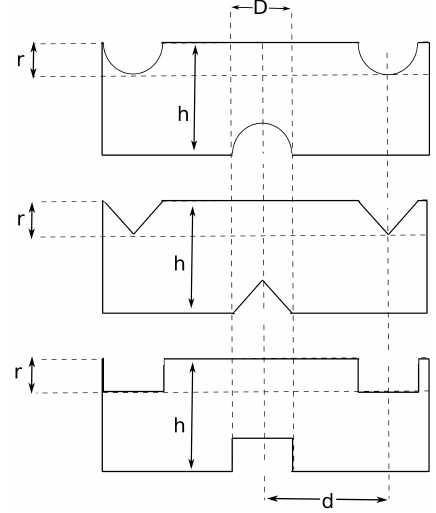
Figure 4. Schematic of the different corrugations (cylindrical, triangular and square) with characteristic parameters. Table 1. Characteristic parameters of corrugated